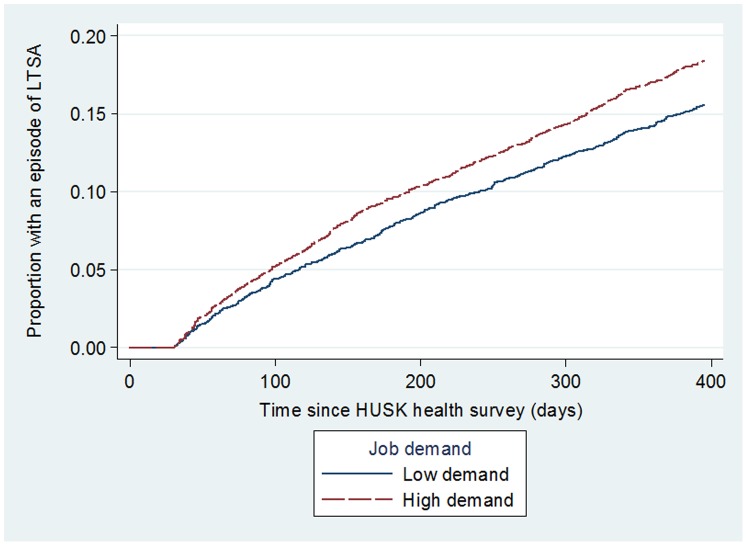
Unadjusted risk of participants having an episode of long term sickness absence (LTSA) by job demand.